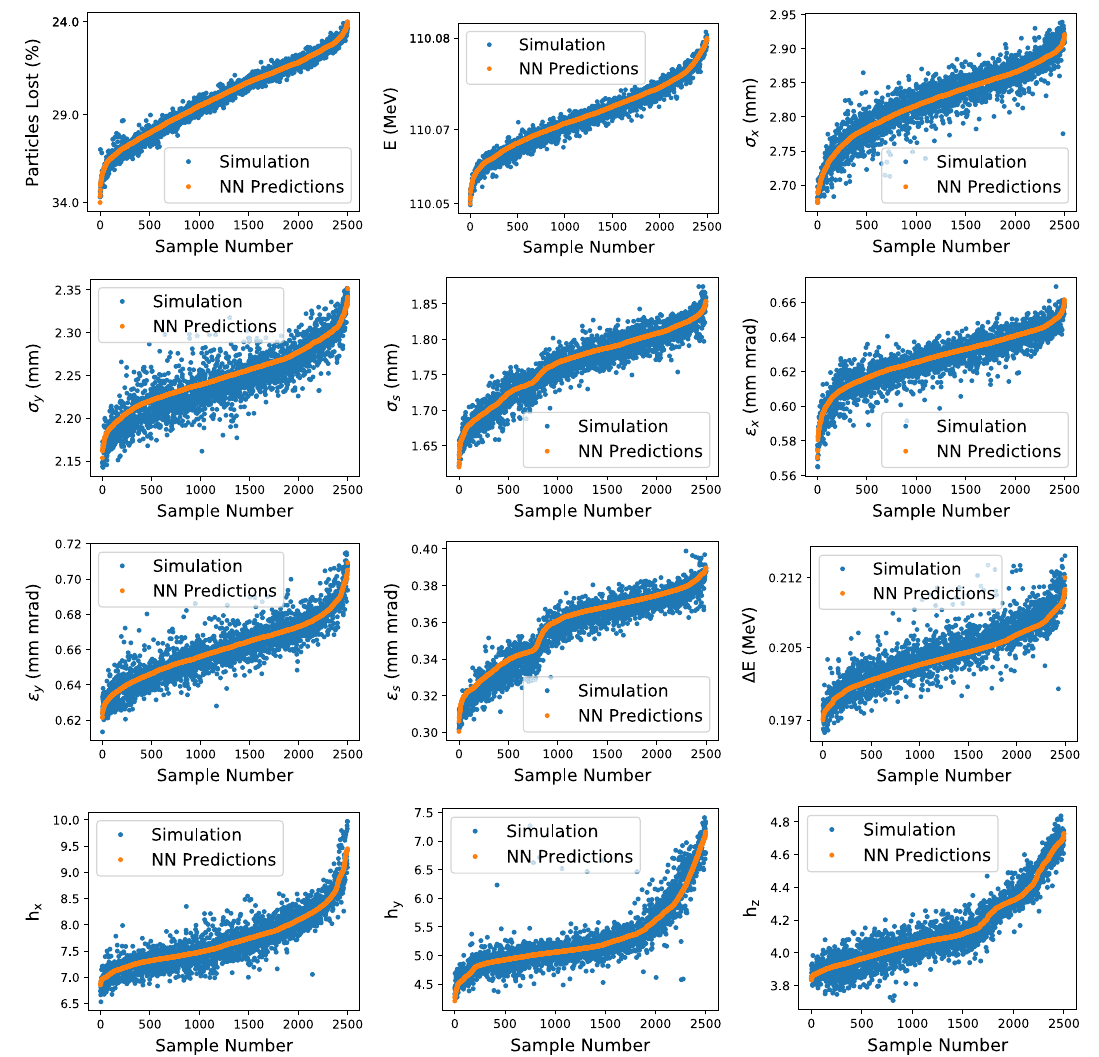
FIG. 15. Example predictions from IsoDAR model trained on 12 outputs and corresponding values from the